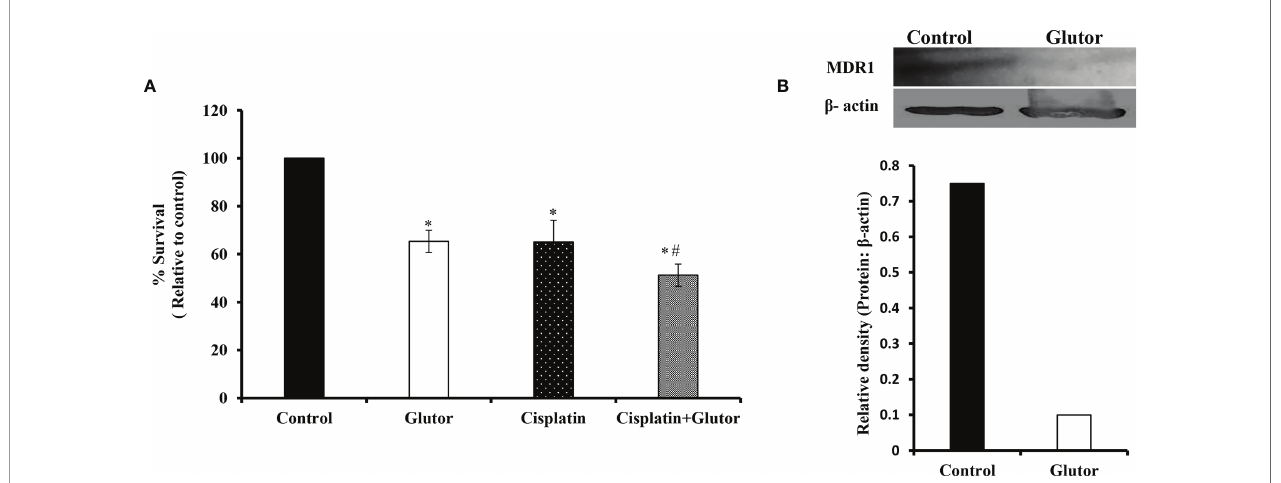
FIGURE 8 | Chemosensitizing action of glutor DL cells (1 × 10 5 ) were incubated in a medium alone or containing glutor (0.01 µM) for 24 h in the presence or absence of cisplatin, followed by estimation of cell survival (A) by MTT assay as described in the Materials and Methods section. Control and glutor-treated DL cells were also evaluated for MDR1 expression (B) by Western blotting. Values in (A) are the mean ± SD. The plates shown in (B) are from a representative experiment out of at least two experiments with similar results. The accompanying bar diagram depicts the densitometry of the bands. *p< 0.05 vs. respective control; p< 0.05 vs. DL cells treated with glutor or cisplatin alone.